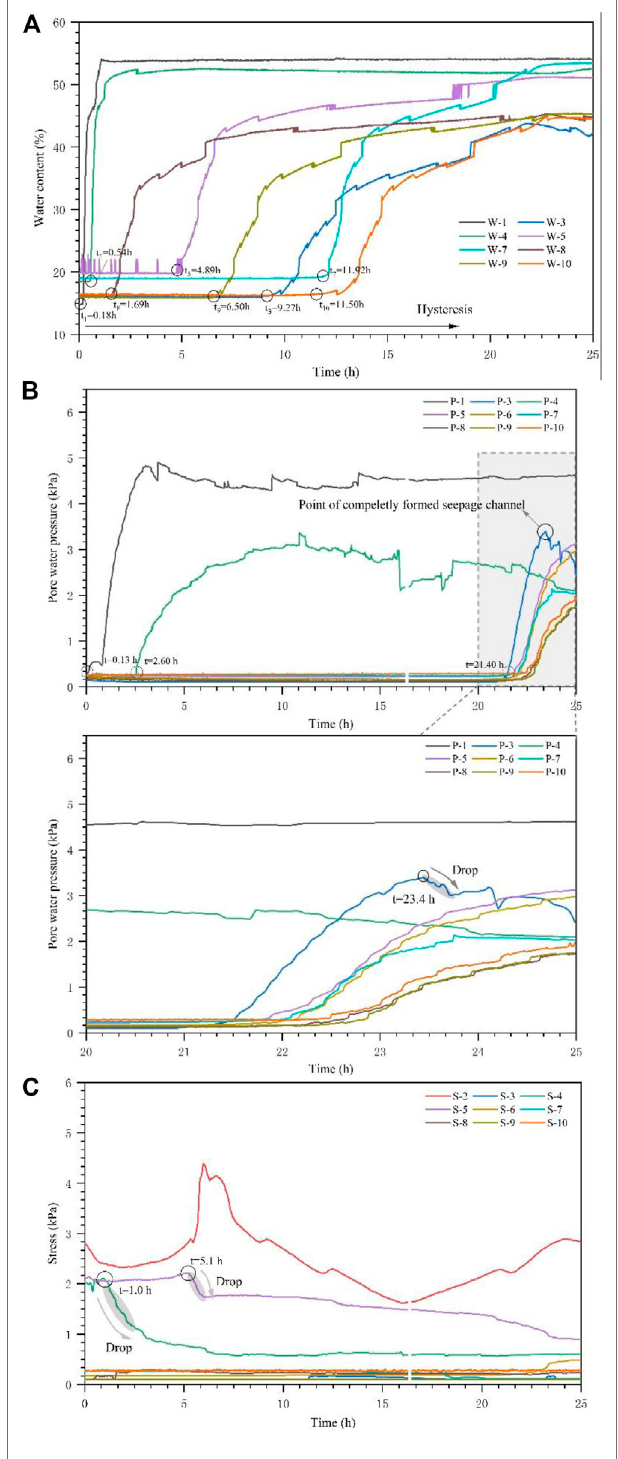
FIGURE 7 | Variation of water content, pore water pressure and soil stress during seepage process. (A) Water content, (B) pore water pressure, and (C) soil